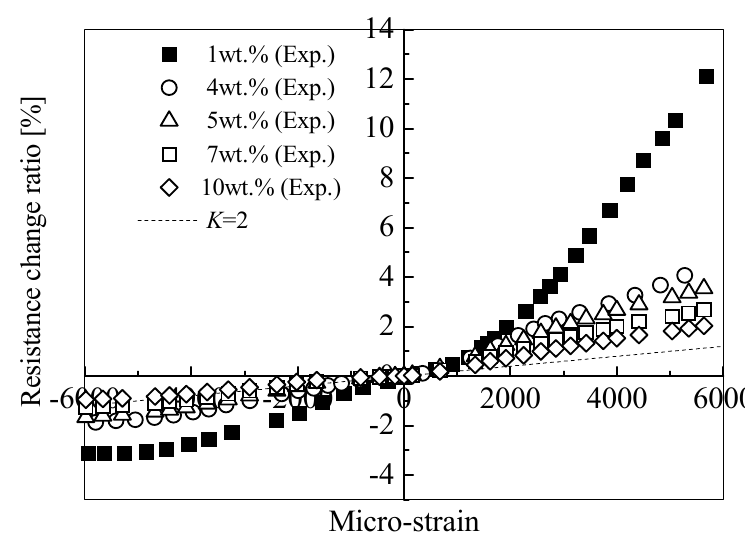
Figure 15. Piezoresistivity of sensor using MWNT-7.